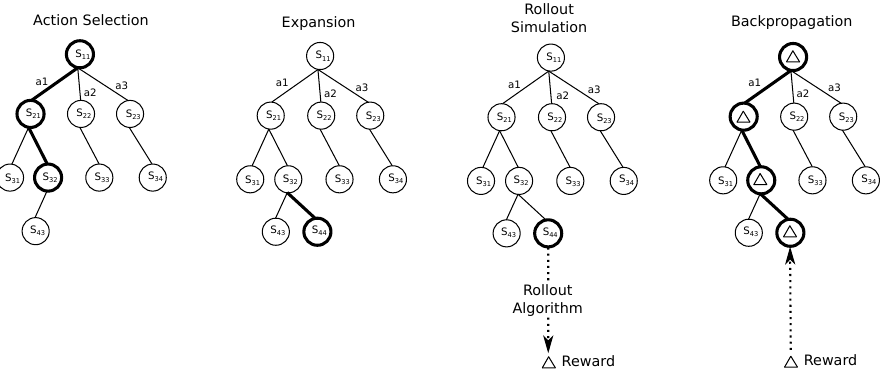
Figure 1. Monte Carlo Tree Search has four steps: action selection, expansion, rollout, and